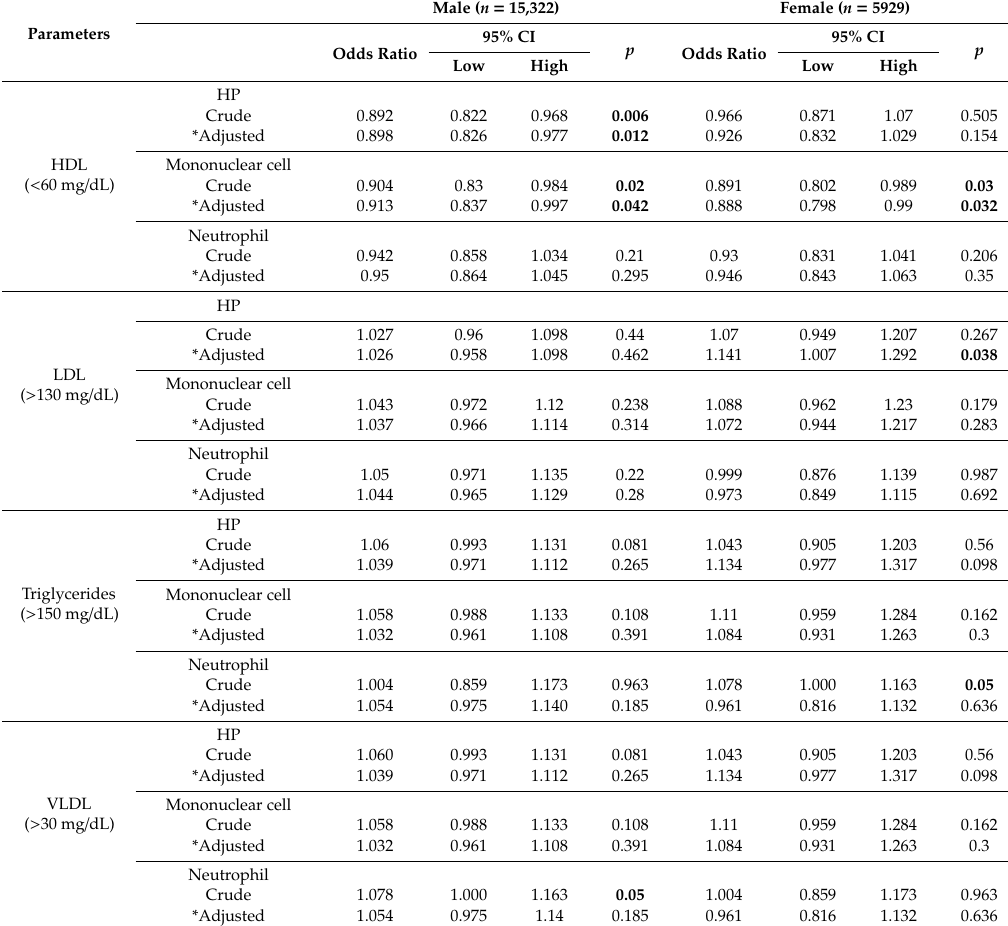
Table 3. Multivariate binary logistic analyses of LDL, VLDL, triglycerides and HDL according to Helicobacter pylori , mononuclear cells and neutrophils using updated Sydney system (USS).